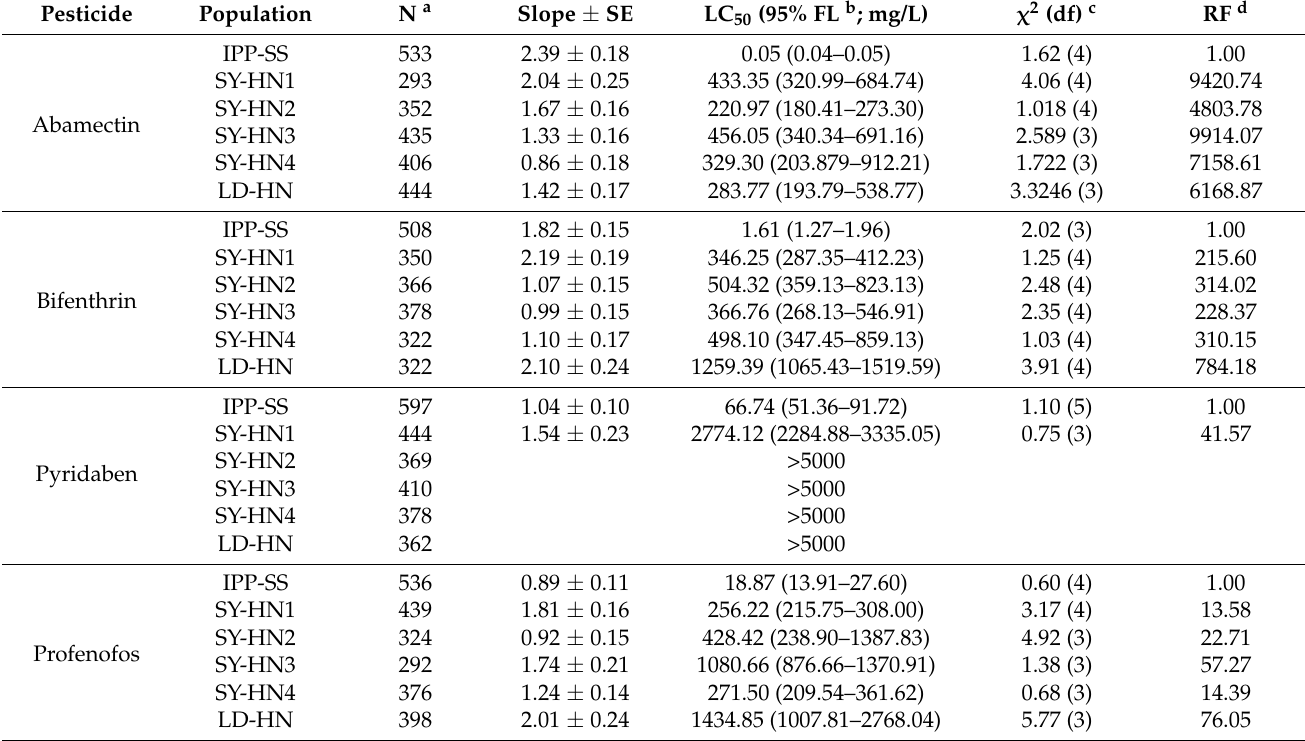
Table 2. Resistance of T. urticae populations from Hainan to abamectin and three traditional pesticides.